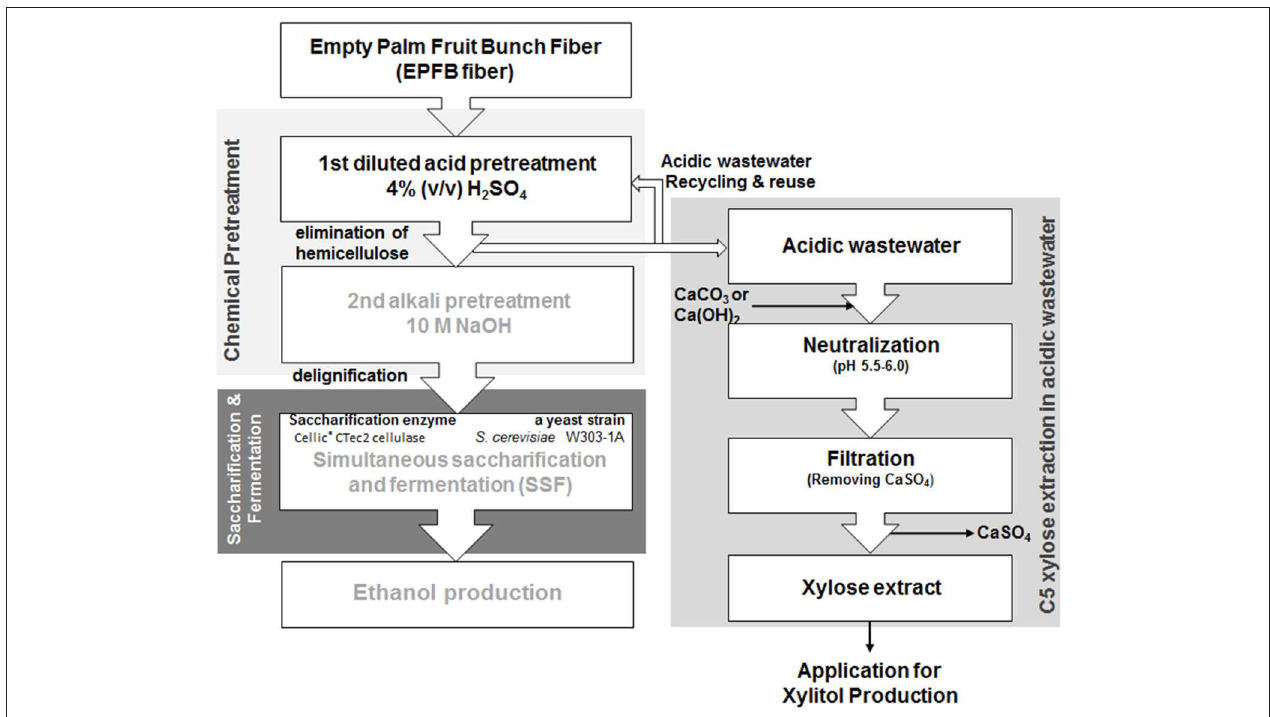
FIGURE 1 | The overall procedure for xylose extraction from the acidic wastewater byproducts generated during the first step of the sequential acid-/alkali-pretreatment process, for utilization of empty palm fruit bunch fiber